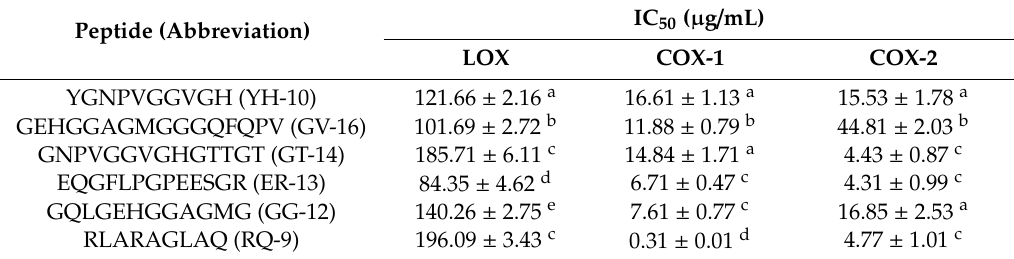
Table 3. IC 50 value of enzymes involved inflammatory process